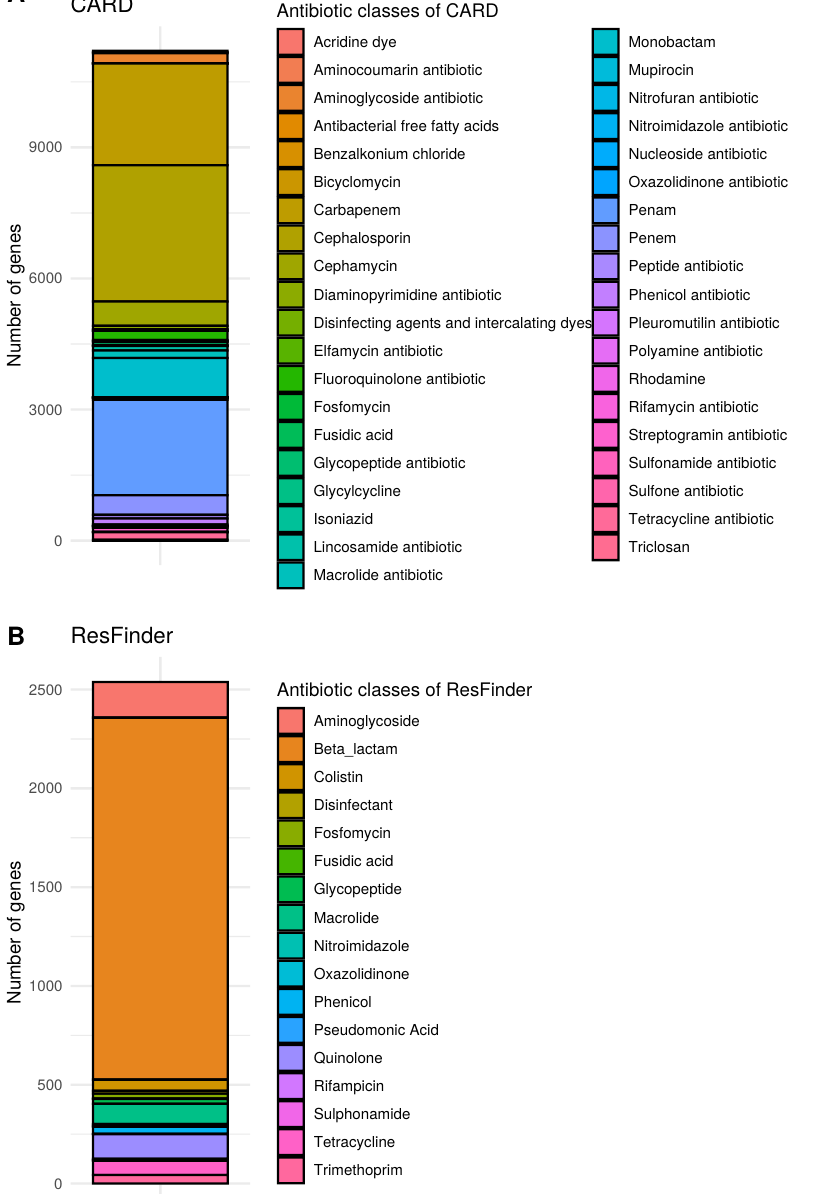
Figure 2. Number of unique genes for each antibiotic class stored in CARD and ResFinder. Bars represent the number of genes in each unique antibiotic or biocide categories, where colors are associated with the specific antibiotics themselves. As one gene can confer resistance to multiple antibiotics, it is possible that the same gene is counted for two or more antibiotics. The plots show the data for CARD ( A ) and ResFinder ( B ),